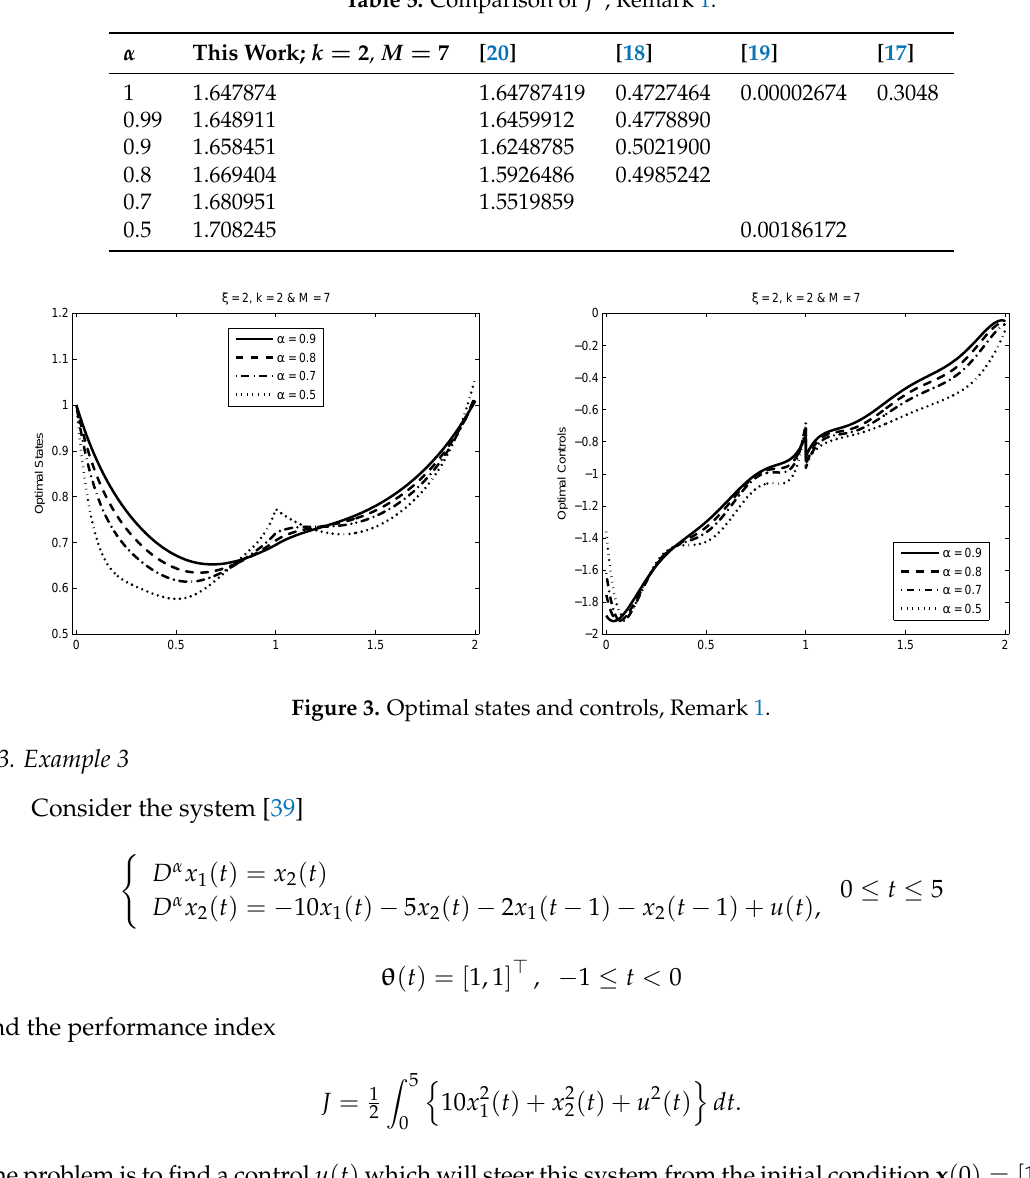
Table 5. Comparison of J ∗ , Remark 1.